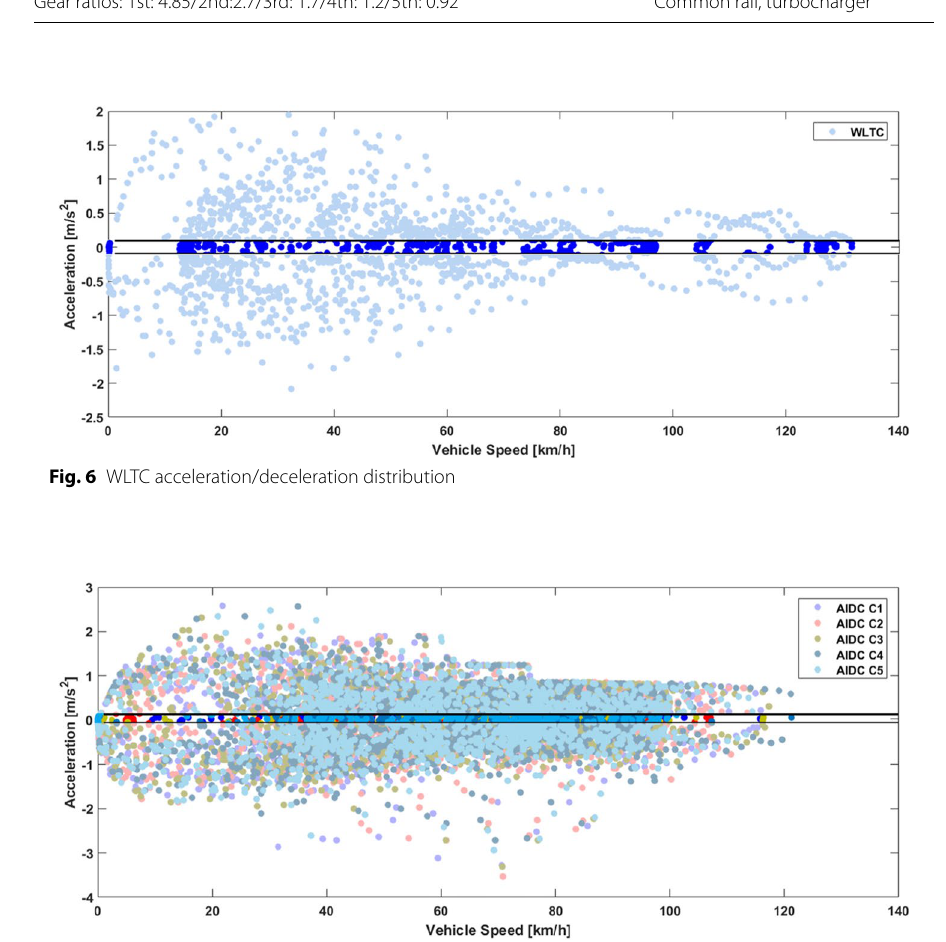
Fig. 7 AIDC acceleration/deceleration